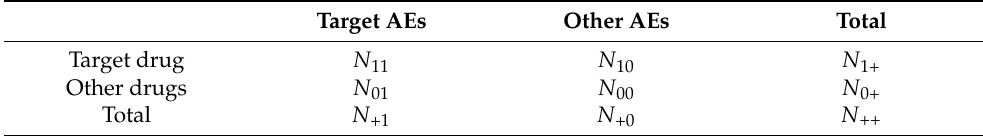
Table 1. The 2 × 2 contingency table for signal detection. Target AEs Other AEs Total Target drug N 11 N 10 N 1+ Other drugs N